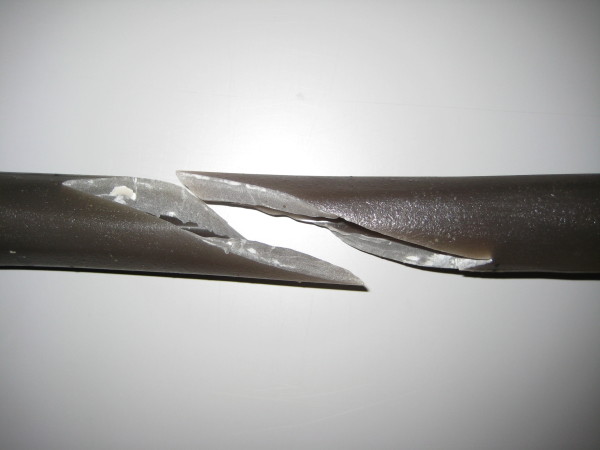
Standard Sawbone® Spiral Fracture.